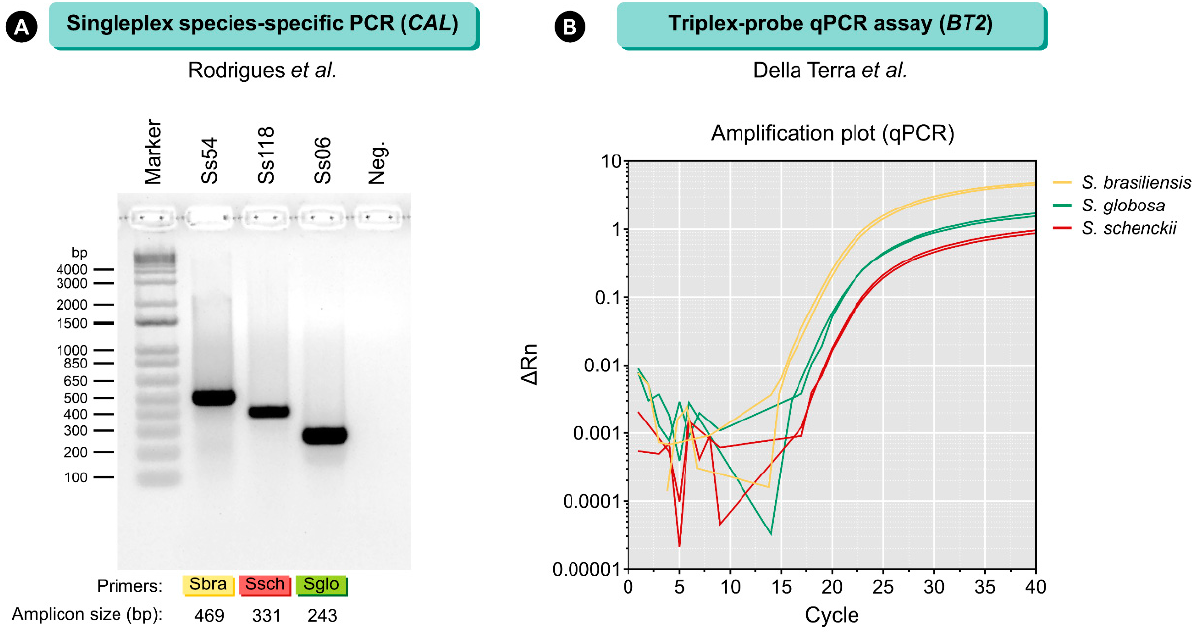
Figure 6. The molecular diagnosis of sporotrichosis relies on PCR. ( A ) Species-specific PCR is a fast and inexpensive method that combines conventional PCR and agarose gel electrophoresis to detect Sporothrix DNA, mainly in vitro culture samples [96]. Eventually, species-specific PCR is used for detection from clinical samples [249]. Although it has great specificity, the method has low sensitivity (up to 10–100 fg of DNA). ( B ) For the rapid and accurate diagnosis of human and feline sporotrichosis, a multiplex qPCR assay was developed for the simultaneous detection and speciation of S. brasiliensis , S. schenckii , and S. globosa from cultured DNA and clinical samples (up to 3 copies of the target) [238]. Ss54 = S. brasiliensis ; Ss118 = S. schenckii ; Ss06 = S. globosa . Della-Terra et al. [238] developed and evaluated a multiplex qPCR assay for sporotri- chosis diagnosis exploiting polymorphisms found in the β -tubulin gene (Figure 6B). Sam- ples of cat lesions and environmental samples spiked with S. brasiliensis , S. schenckii , and S. globosa propagules were used to reveal the feasibility of the method to detect Sporothrix DNA. High specificity (100%) and sensitivity (98.6%) were reported [238]. Moreover,